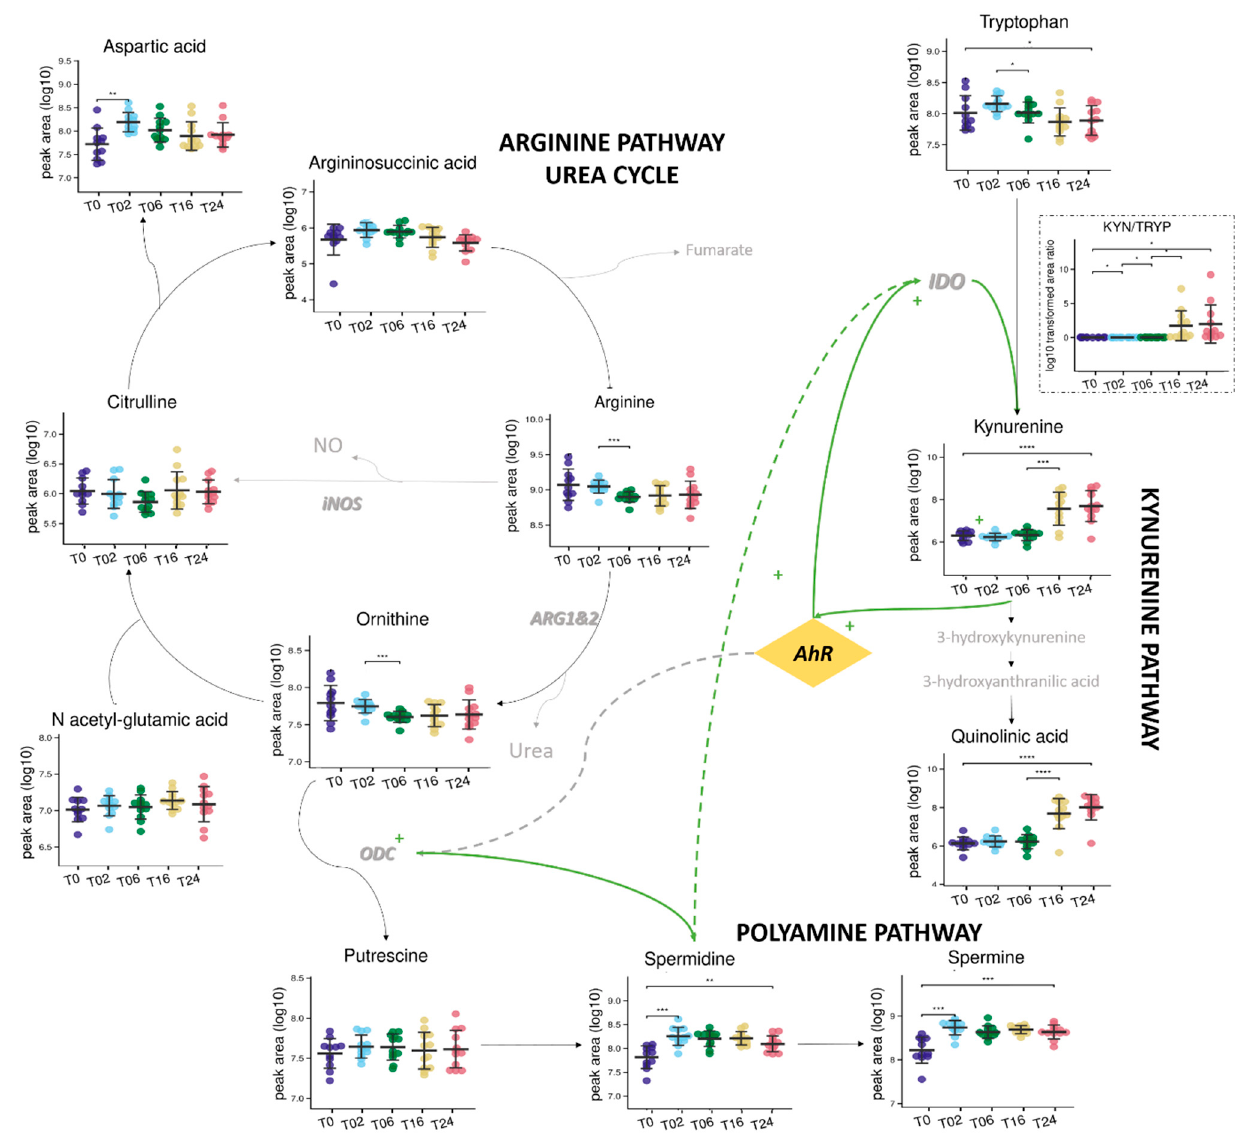
Figure 8. Metabolic coverage of arginine, kynurenine, and polyamine pathways and possible interconnections. Variation in the relative abundance of metabolites (log-transformed, mean values are represented (SD)) from 0 to 24 h of LPS incubation. *: p -values < 0.05 **: p -values < 0.01; ***: p -values < 0.001, and ****: p -values < 1 × 10 − 4 . Metabolites in gray are not detected, iNOS: nitric oxide synthase; ARG1&2: arginase; ODC: ornithine decarboxylase; IDO: Indoleamine-2,3-dioxygenase; AhR: Aryl Hydrocarbon Receptor.